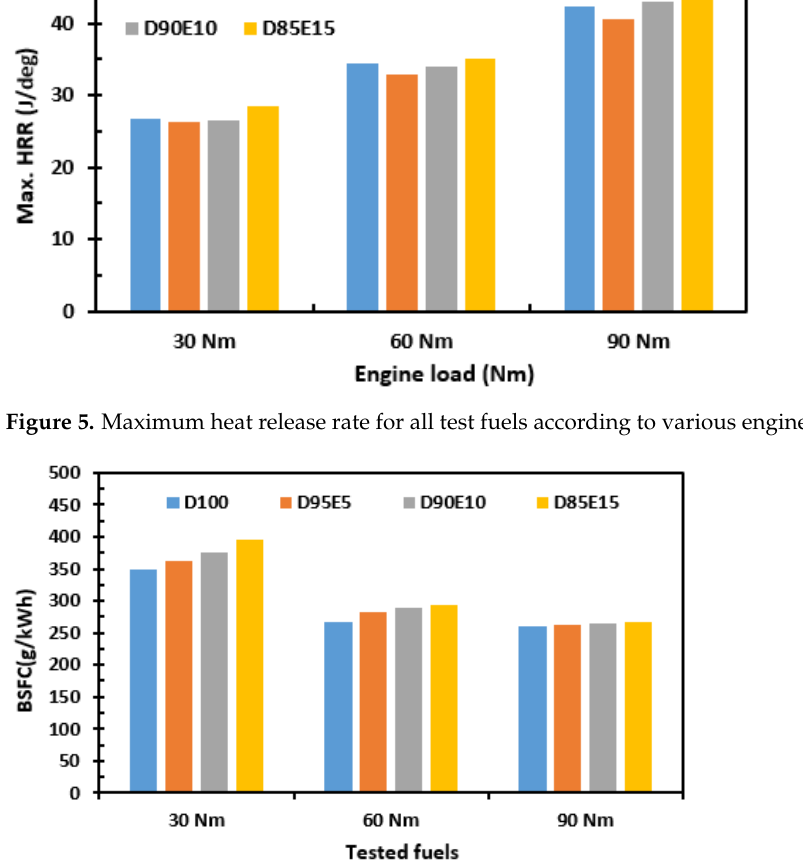
Figure 6. Maximum heat release rate for all test fuels according to various engine loads.